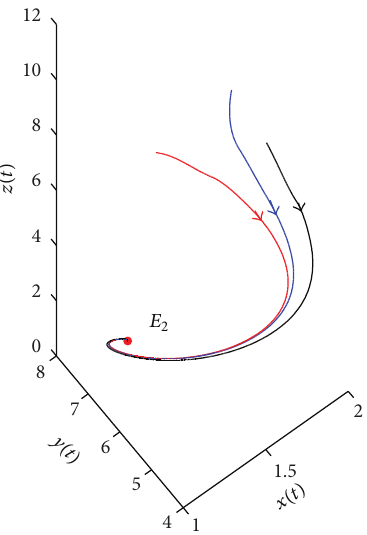
Figure 1: The CTL-present infection equilibrium 𝐸 2 of system (3) is locally asymptotically stable when 𝑅 1 = 1.33 > 1 and 𝜏 = 1.5 .